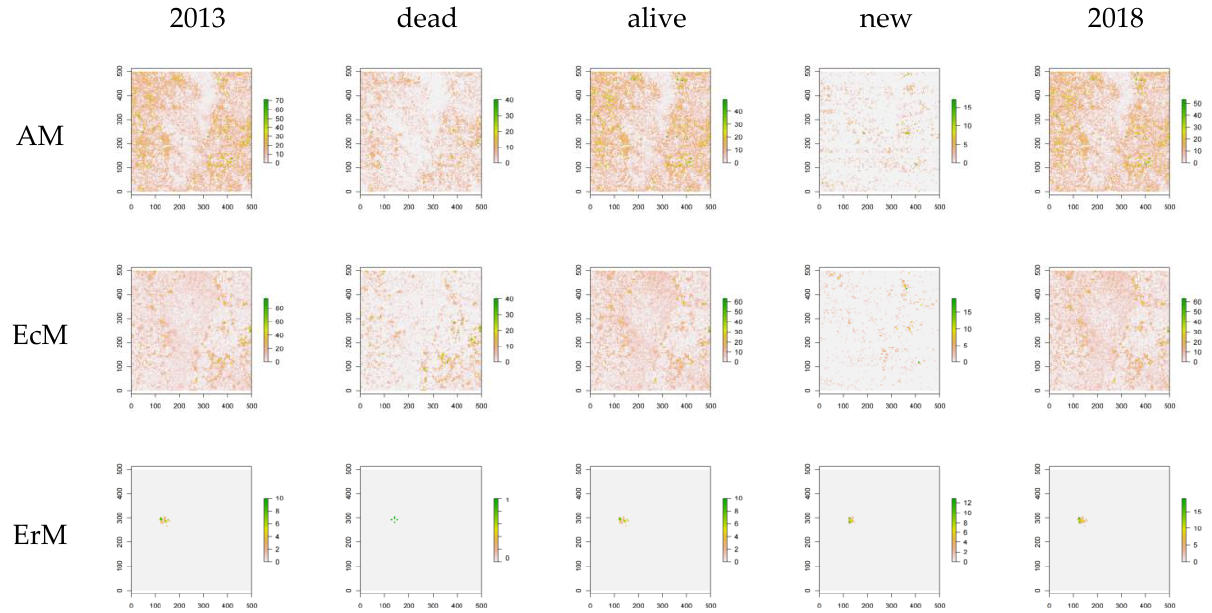
Figure 6. Dynamic distribution diagram of the quantity of tree species of different mycorrhizal types. 2013: trees in 2013; Dead: died trees between 2013 and 2018; Alive: alive trees from 2013 to 2018; New: new trees from 2013 to 2018; 2018: trees in 2018; AM: AM type tree species; EcM: EcM type tree species; ErM: ErM type tree species.